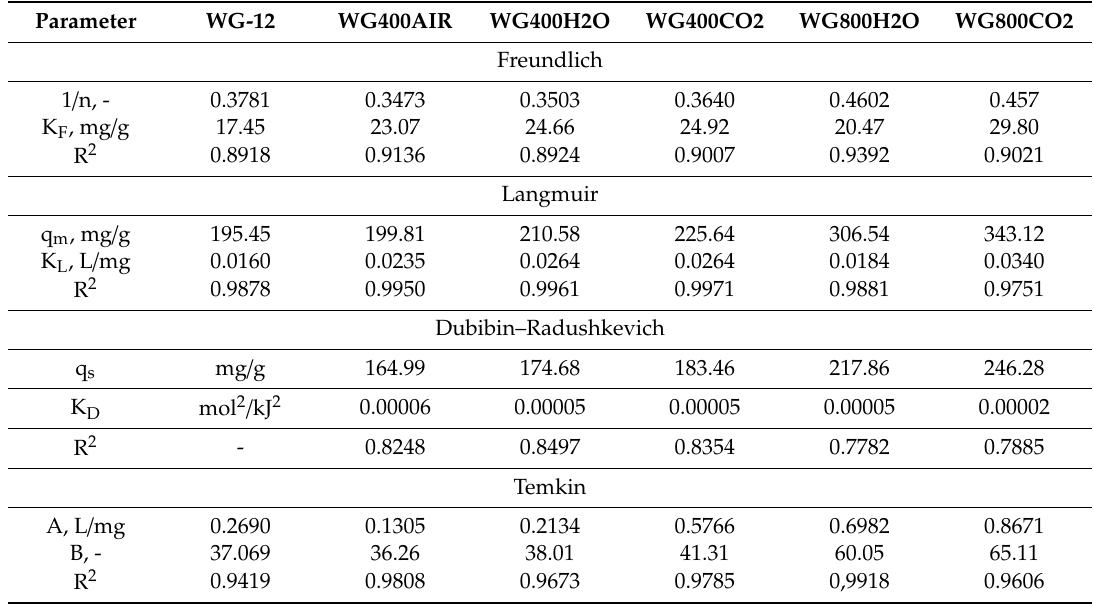
Figure 6. Isotherms of chloramphenicol adsorption on modified activated carbons. Table 9. Isotherms of chloramphenicol adsorption on high-temperature modified activated